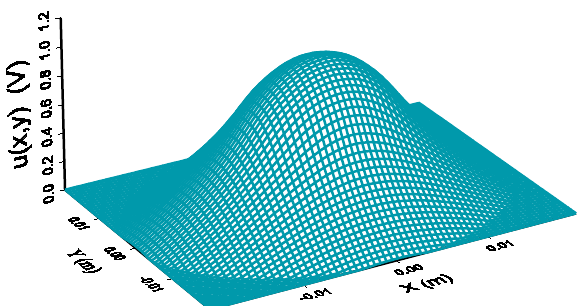
FIG. 2. (Color) The space charge potential u (cid:1) x , y , z (cid:1) 0 (cid:2) calcu- lated by the SOR-3D method for the bunch of Fig. 1.